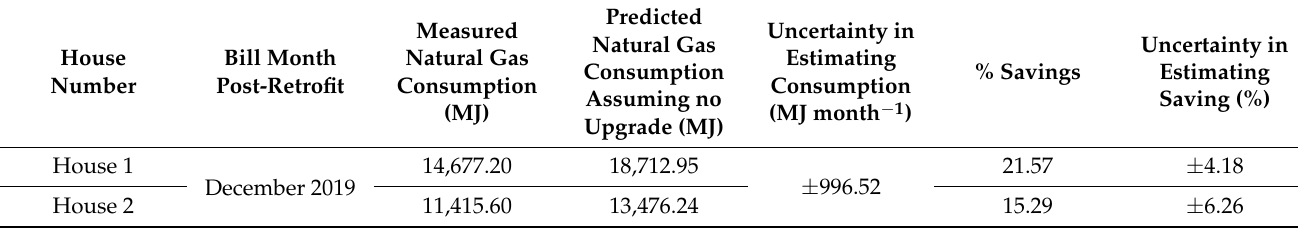
Table 7. Savings percentage and uncertainty for an attic